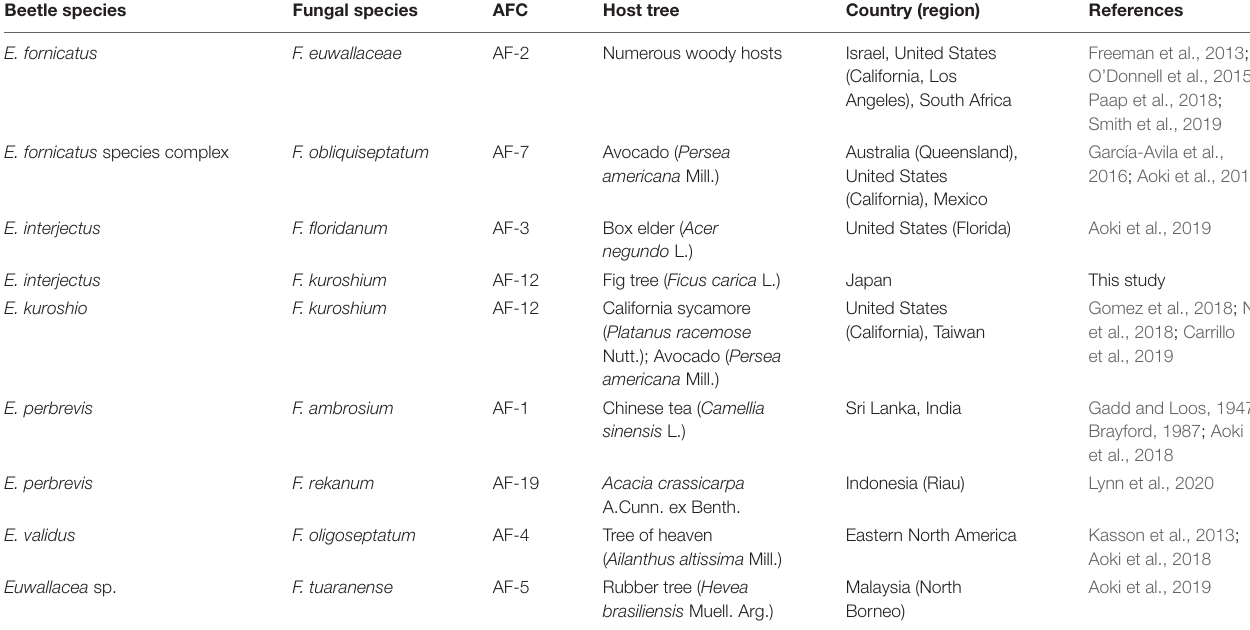
TABLE 1 | A worldwide summary of Euwallacea beetle– Fusarium fungus symbiosis in relation to tree damage.